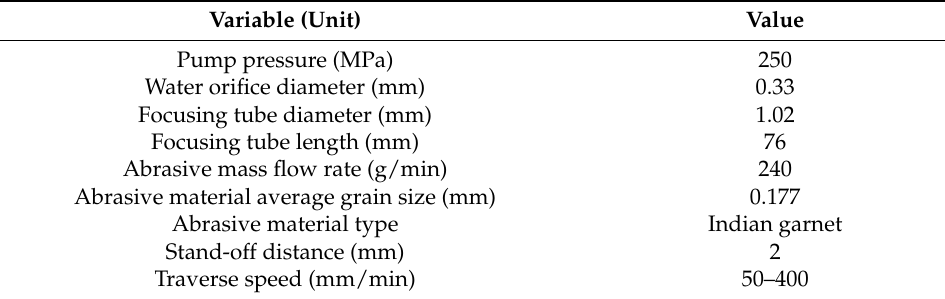
Table 1. Summary of factors and settings in experiments.